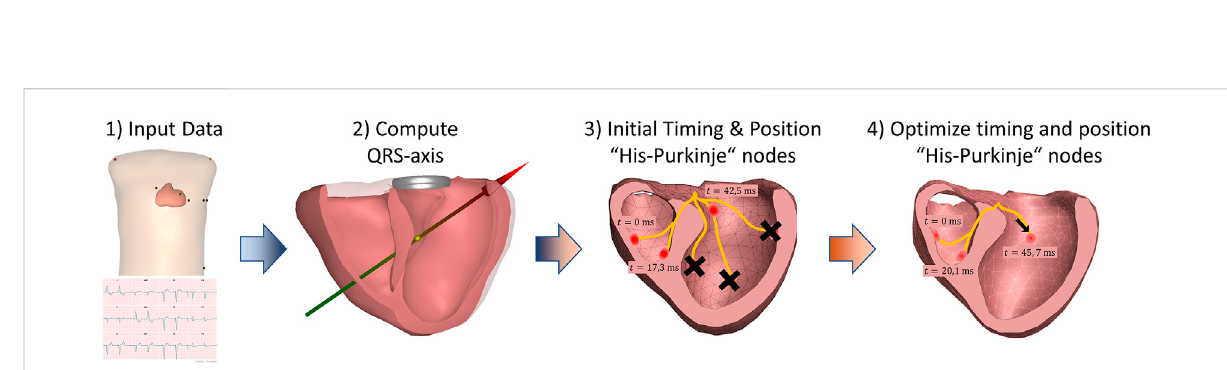
FIGURE 3 The steps involvedin The Mapper algorithm. 1) First, ageometry (generic or patient speci fi c) and a patient speci fi c 12-leadECG is used as input. 2) Initial analysis of the QRS axis and QRS duration determines gross activation pattern, and based on this3) pre-de fi ned times are set for the six His- Purkinjeactivationsites(orsitesare “ disabled ” ).Finally,4)boththepositionandtheactivationtimesoftheHis-Purkinjeactivationsitesarechangedto best fi t the